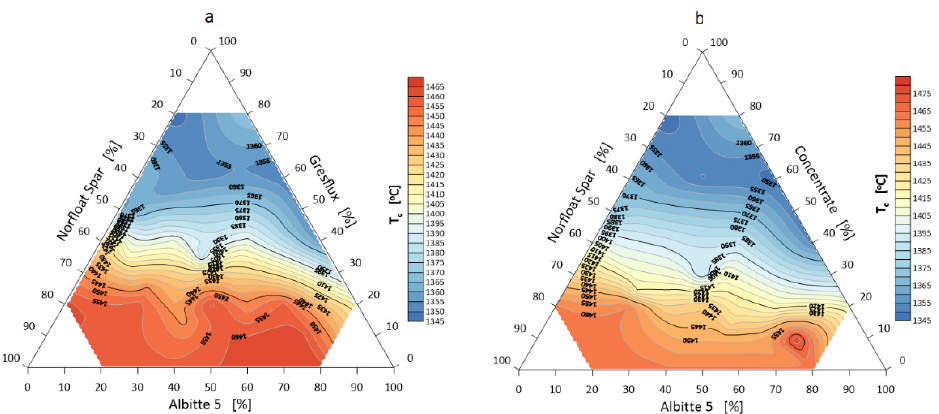
Figure 6. The beginning of the flux system spreading T c , Greflux–Albitte 5–Norfloat Spar ( a ), and Concentrate–Albitte 5–Norfloat Spar ( b ).